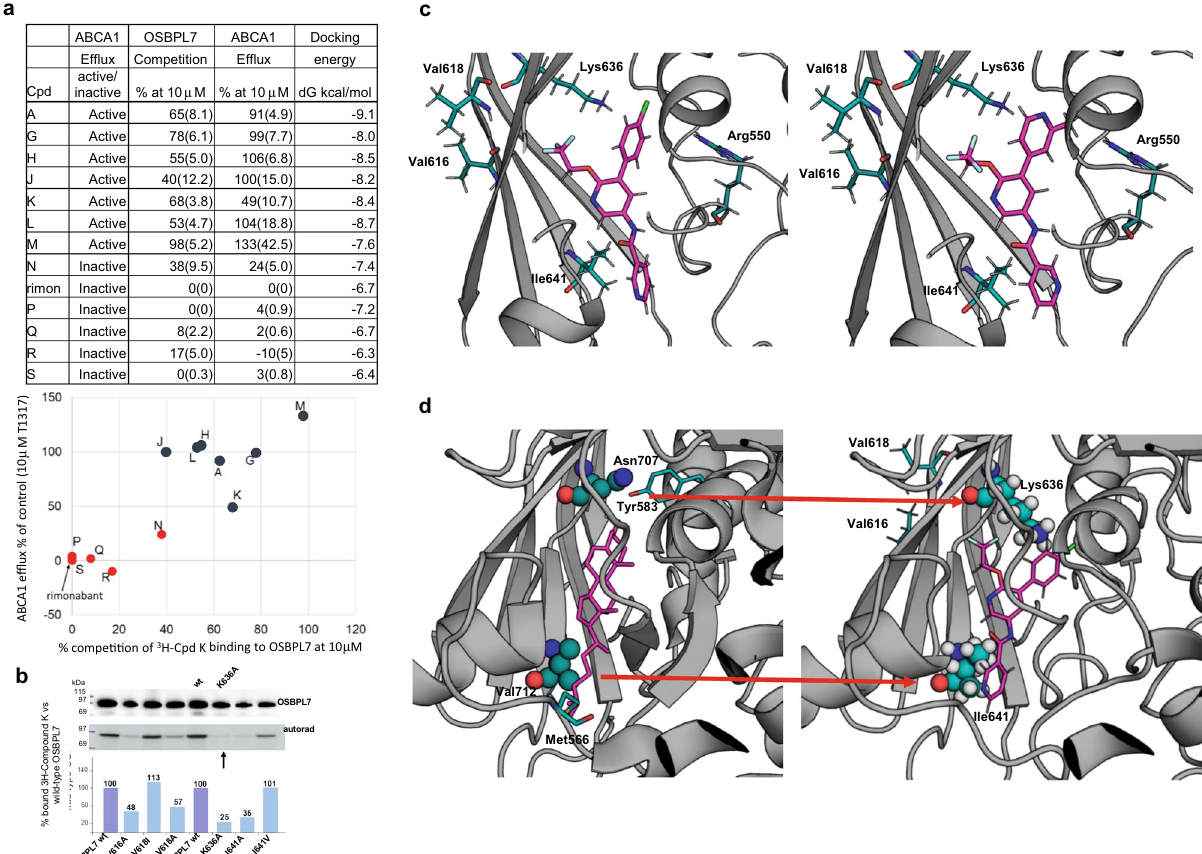
Fig. 3 The 5-arylnicotinamides interact with the predicted OSBPL7 sterol binding domain. a Twelve 5-arylnicotinamides (7 active, 5 inactive) and rimonabant were used to explore the correlation between their ability to induce ABCA1-mediated cholesterol ef fl ux in THP1 cells and their ability to compete with 3 H Cpd K binding to OSBPL7. The table summarizes the ABCA1 ef fl ux data for the selected set, the binding data results generated for OSBPL7, as well as the docking energies calculated from the homology model. This is the complete dataset including all Cpds evaluated for OSBLP7 binding. The graph depicts the relationship between ABCA1 ef fl ux activity and ability to compete with 3 H Cpd K binding to OSBPL7. Cpds A, G, H, J, K, L, M were scored as active (>50% increase in cholesterol ef fl ux in THP1 cells vs. the effect of T1317) while Cpds N, P, Q, R, S and rimonabant were scored as inactive (<50% increase in cholesterol ef fl ux). The ef fl ux data strongly correlated with the ability of these Cpds to interact with OSBPL7. b Evaluation of 3 H Cpd K binding to wildtype OSBPL7 (wt) and various single mutations introduced into the putative ORD. Mutation of K636A reduced 3 H Cpd K binding by ~75% suggesting that Lys 636 is the site of covalent interaction via its reactive azide group. Representative data from three independent experiments, full western blot shown in Supplementary Fig. 3). c The predicted best poses and energies for binding of active Cpd M (left panel) to OSBPL7 in comparison to inactive Cpd R (right panel). Both compounds make a clear π -cation interaction with the catalytic Lys636. However, R, which has a higher GlideScore, fi ts the binding site less well due to the methyl group of the 4-pyridine ring which appears too close to the positively charged Arg550. d Left image: Focus on the binding site of the cholesterol/ORP1-ORD complex (pdb code 5zm5). Right image: Focus on the binding site of the Cpd M/OSBPL7 complex. The ligands are displayed as ball- and-stick models with the carbon atoms colored in magenta. The residues that occupy equivalent positions are indicated by the fi lled